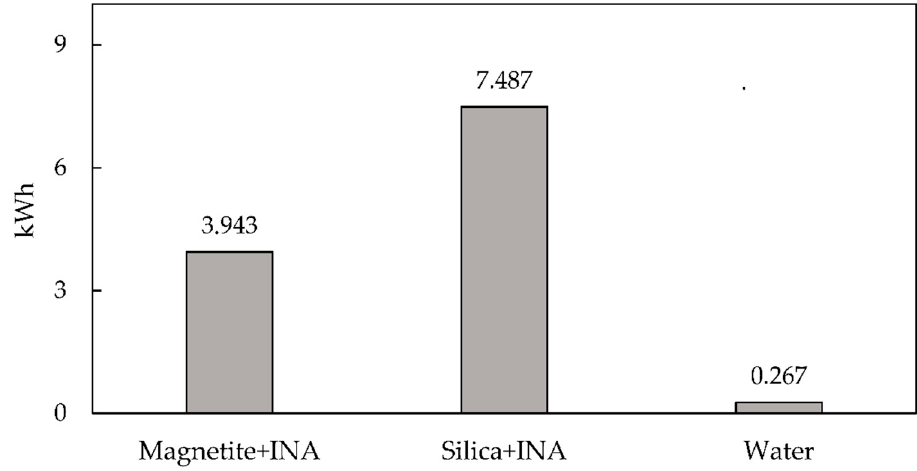
Figure 2. Energy consumption of the manufacturing stage for bionanocompounds and water.